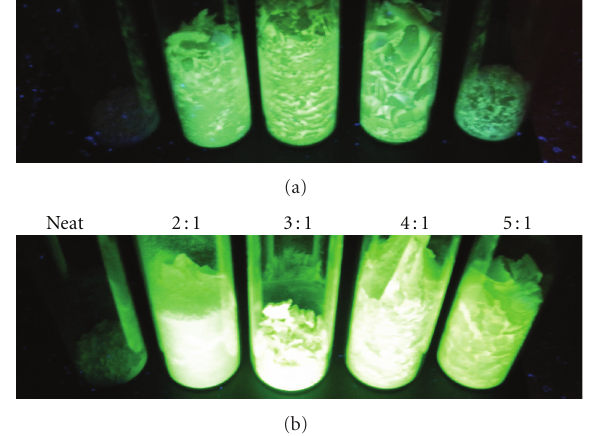
Figure 10: Neat PMMA and PMMA nanocomposites composed of varying ratios of (a) PA:Tb 3+ :LaF 3 and (b) ASA:Tb 3+ :LaF 3 under UV